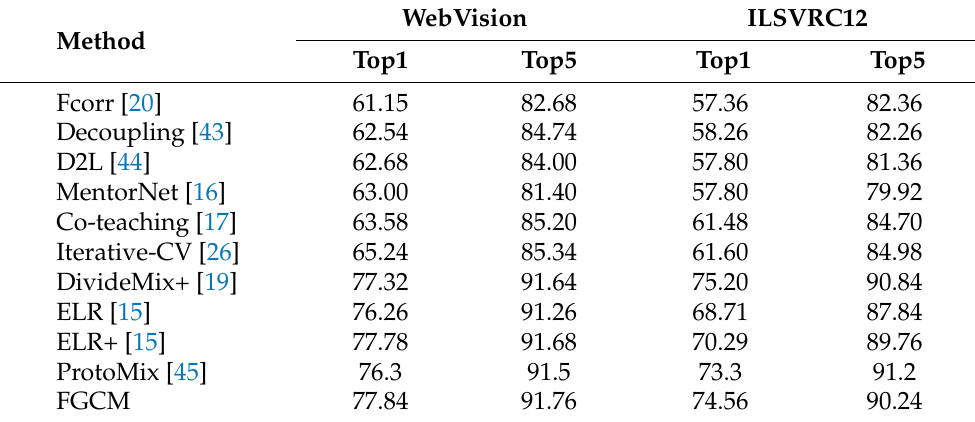
Table 5. Performance comparison with state-of-the-art methods on WebVision validation set and the ImageNet ILSVRC12 validation set. Results for baseline methods are copied from [12,15,19].